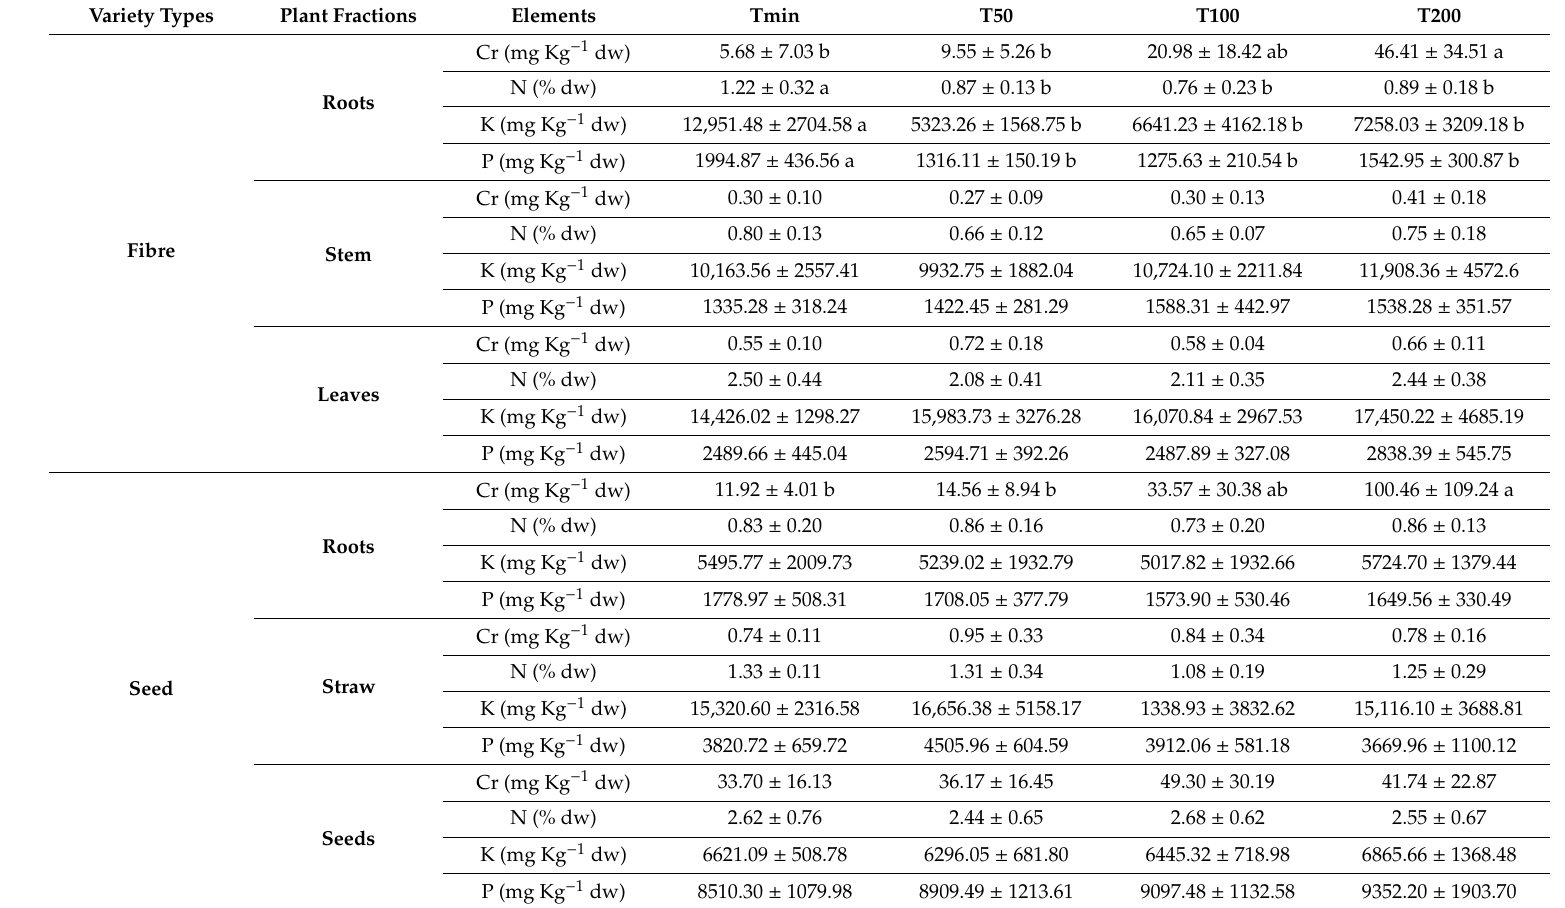
Table 2. Chromium and macronutrient concentrations in the hemp